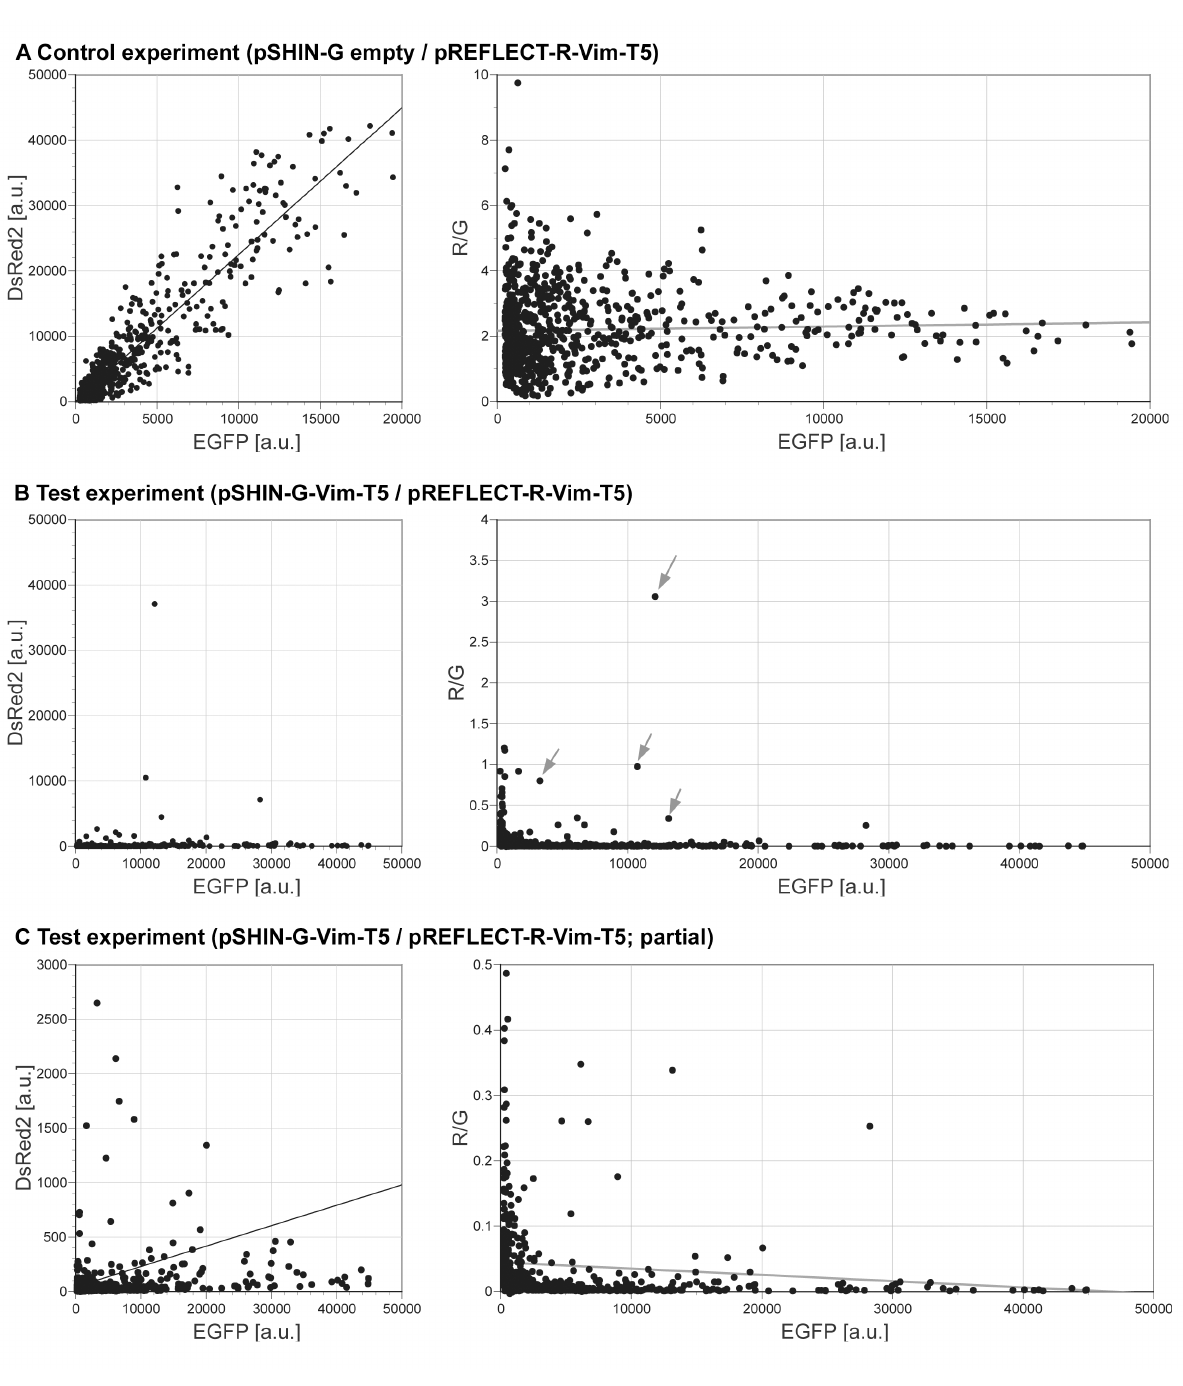
Supplemental Figure 4. Scatter plots of dual fluorescence assay. Rat2 cells were transfected with combination of either pSHIN-G empty vector plus pREFLECT-R(DsR)-Vim-T5 ( A ) or pSHIN-G-Vim-T5 plus pREFLECT-R(DsR)-Vim-T5 ( B & C ). The EGFP and DsRed2 fluorescence intensities were measured for individual nuclei of transfectants expressing EGFP. The x-axis indicates the EGFP intensity. The y-axis indicates either the DsRed2 intensity (left) or the R/G ratio (right). The same data set is shown in B and C with different scales. The arrows indicate examples of the outliers with unusually high red